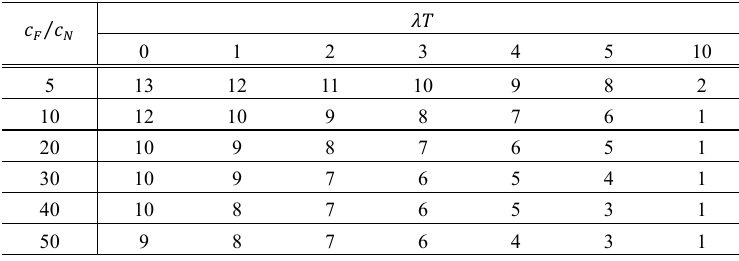
Table 2. Optimal 𝑁 0∗ when 𝜔𝐾 =